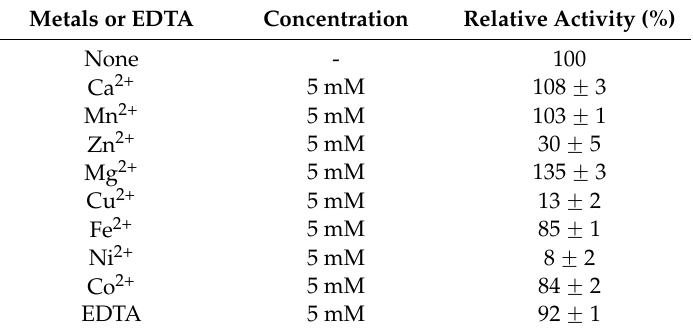
Table 2. Effect of various metals and EDTA on the synthesis activity of Suc6A of r ‐ Ao FT a . Metals or